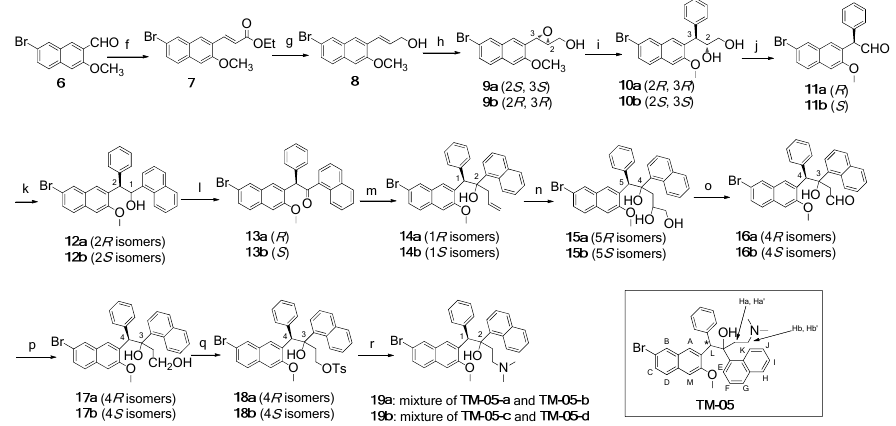
Scheme 1. Asymmetric synthesis of four isomers of TM-05 . Reagents and conditions : ( f ) NaHMDS,